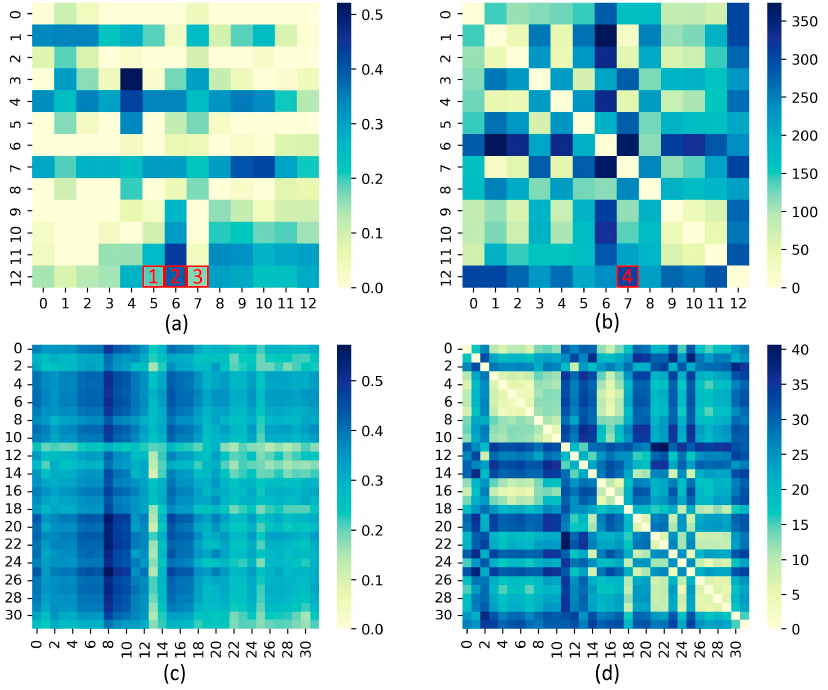
Figure 4. ( a ) Time Encoder attention map (upper–left); ( b ) Time Encoder DTW (upper–right); ( c ) Behavior Encoder attention map (bottom–left); ( d ) Behavior Encoder L2 distance (bottom–right).